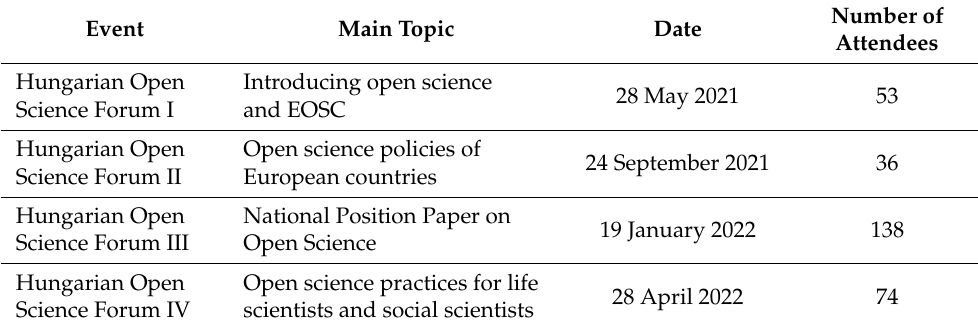
Table 3. Number of attendees of the Hungarian Open Science Forum events.